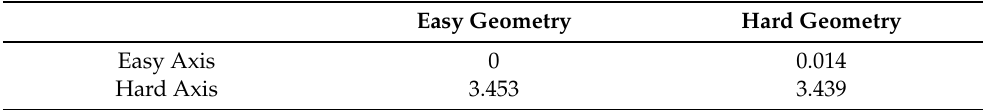
Table 2. Relative energies (in meV/formula unit) for the various configurations of spin and geometry in FePt. The easy geometry is the ground-state geometry of the system, and the hard geometry is the relaxed geometry of the system under the constraint that the system is aligned along the magnetic hard axis. Easy Geometry Hard Geometry Easy Axis 0 0.014 Hard Axis 3.453